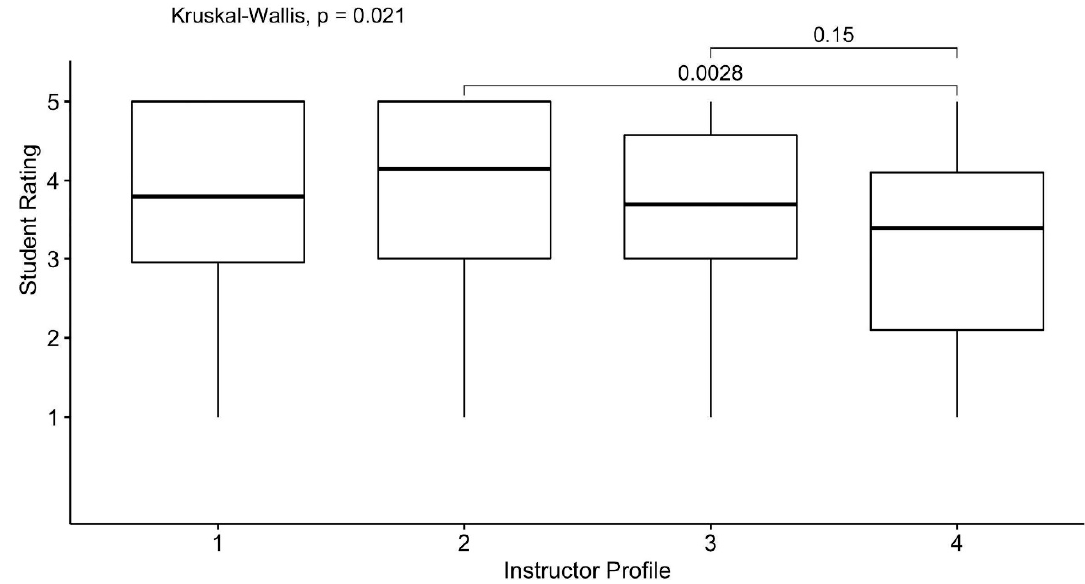
Figure 11. Ratings according to online content courses and instructor profile. Instructor 1 is a native speaker from Spain, Instructor 2 is a native speaker from Latin America, Instructor 3 is a Heritage Speaker of Spanish, and Instructor 4 is an L2 Spanish speaker.